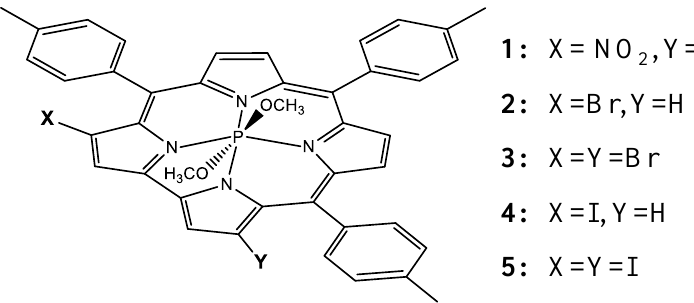
Scheme 1. Schematic representation of compounds investigated in this work.